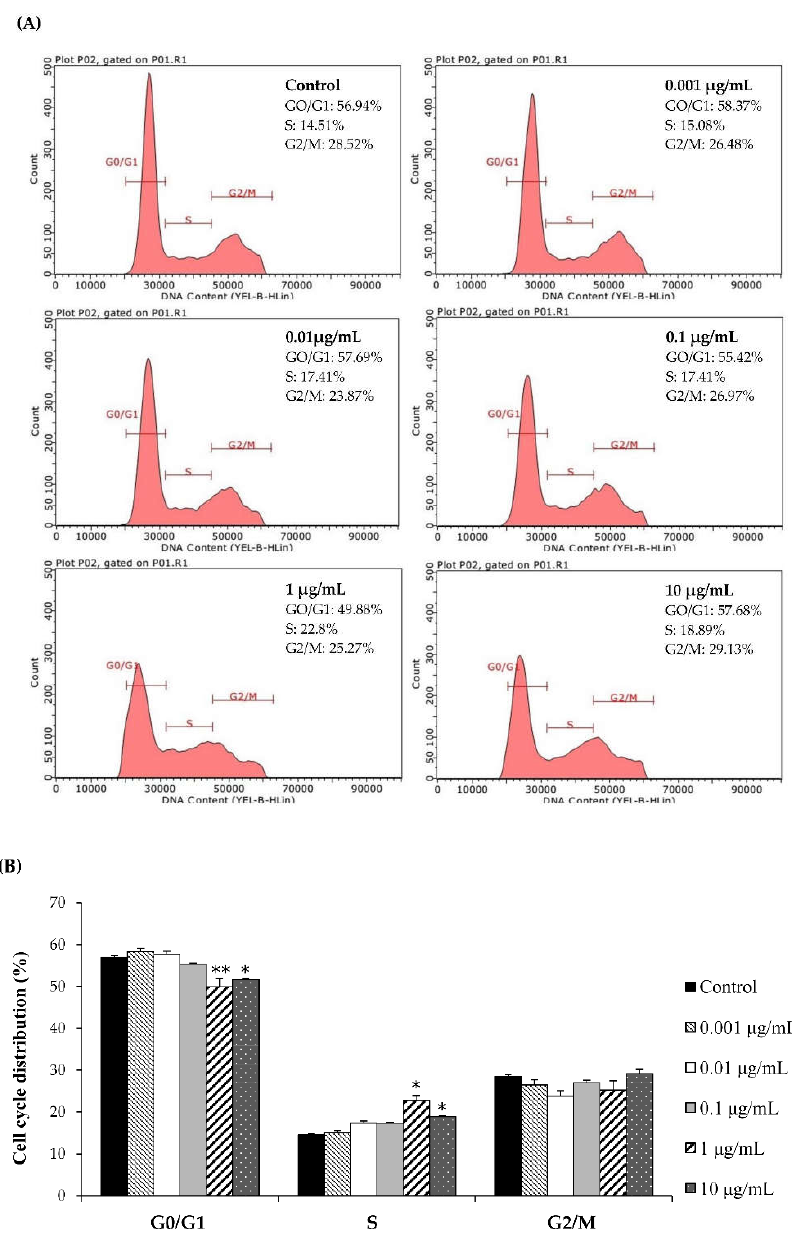
Figure 2. The effect of Ps -GOS on the division of cell. ( A ) A pictorial graph shows the result from flow cytometry analysis after osteoblastic cells were treated with the different concentrations of Ps -GOS for 48 h. ( B ) The result shows the percentage of osteoblastic population of G0/G1, S, and G2/M cell cycle phases, compared with the control. Each point of data represents the means of three replicate samples ± SEM. * = p < 0.05, ** = p < 0.01 when compared to the control.